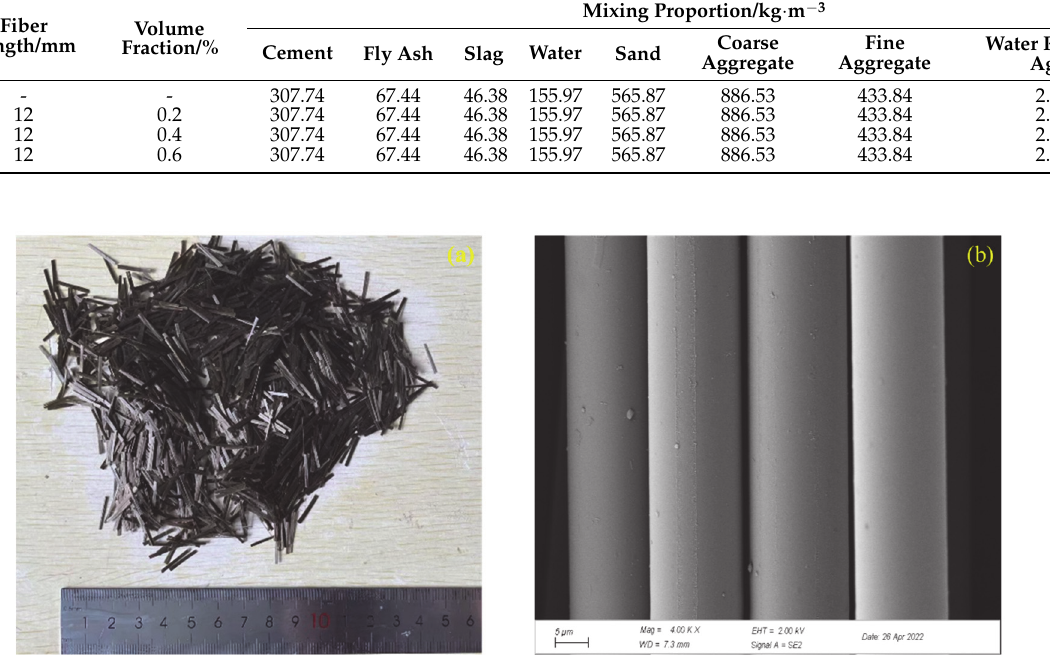
Figure 1. ( a ) Macro and ( b ) micro morphologies of BF. Table 2. Physical and mechanical indices of basalt fiber.